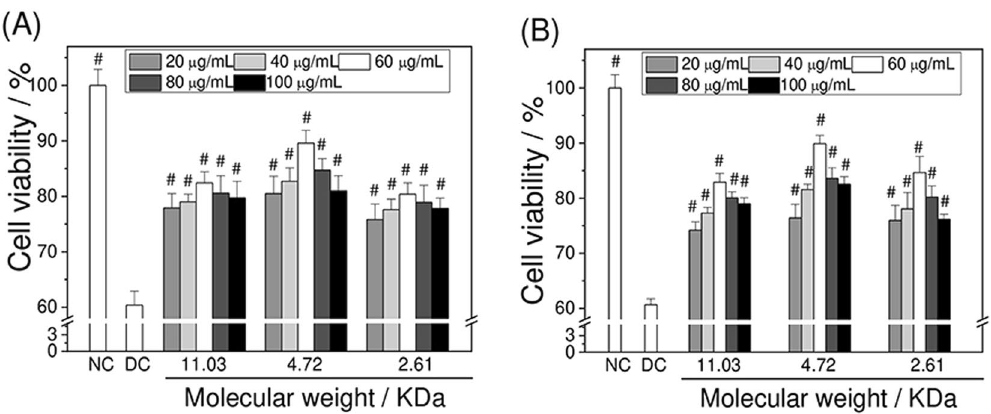
Figure 2. Changes in cell viability of damaged HK-2 cells after being repaired by different Mw APS detected by CCK-8 ( A ) and MTT ( B ) methods, respectively. Normal Control (NC); Oxalate damaged control (DC). Oxalate concentration: 2.6 mM. Damaged time: 3.5 h; Repaired time: 10 h. Compared with DC group, * p < 0.05, # P < 0.01.